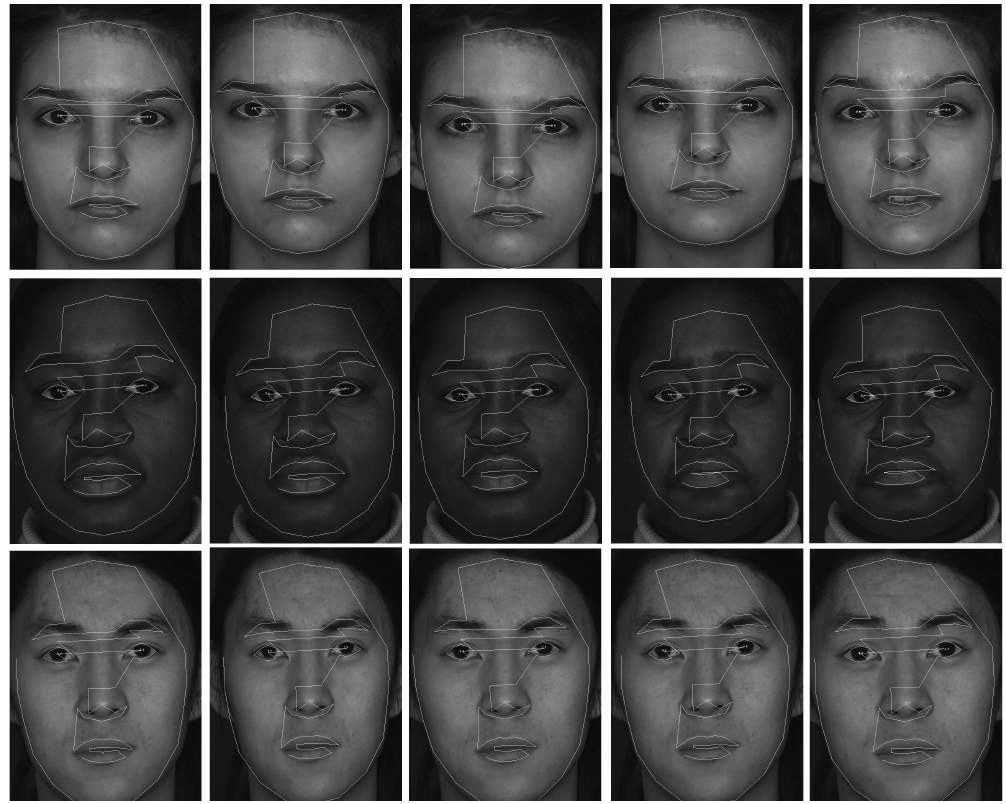
Figure 1. Sample images with 2D feature tracks from the BU-4DFE